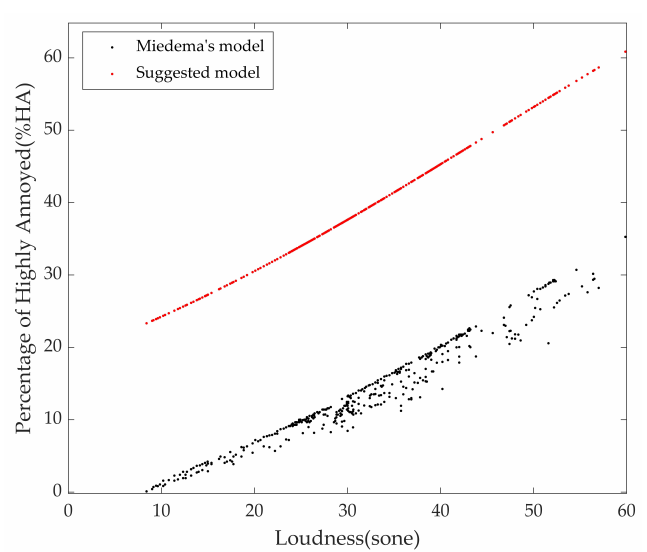
Figure 14. Comparison between the suggested model in this study and Miedema’s annoyance